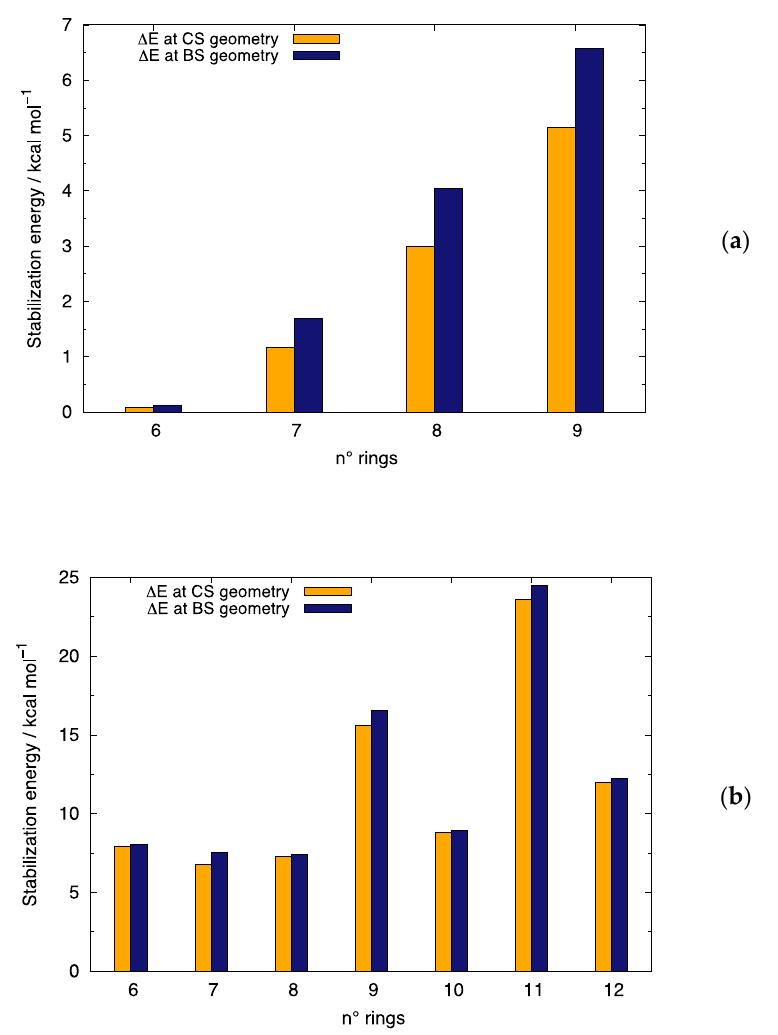
Figure 2. Comparison between the total stabilization energy ( ∆ E at BS geometry) and the stabilization energy due to the relaxation of the constraint of same spatial occupation for α and β electrons in the unrestricted wavefunction ( ∆ E at CS geometry). From B3LYP/6-31G* calculations: ( a ) [n]-acenes displaying an open-shell structure and ( b ) even and odd [n]-CCs .